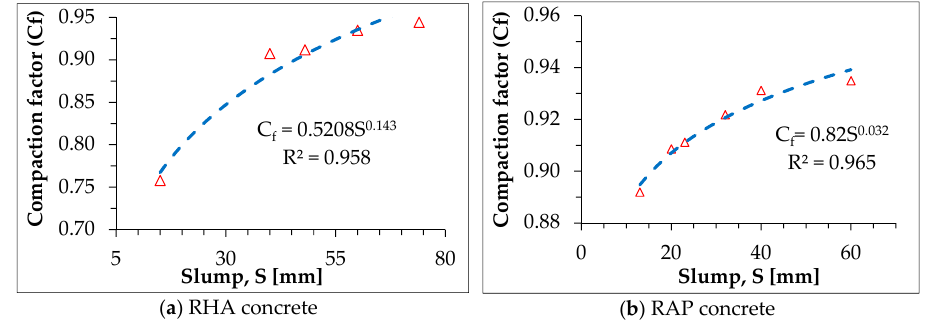
Figure 4. Relationship between slump and compaction factor for RHA and RAP concrete.